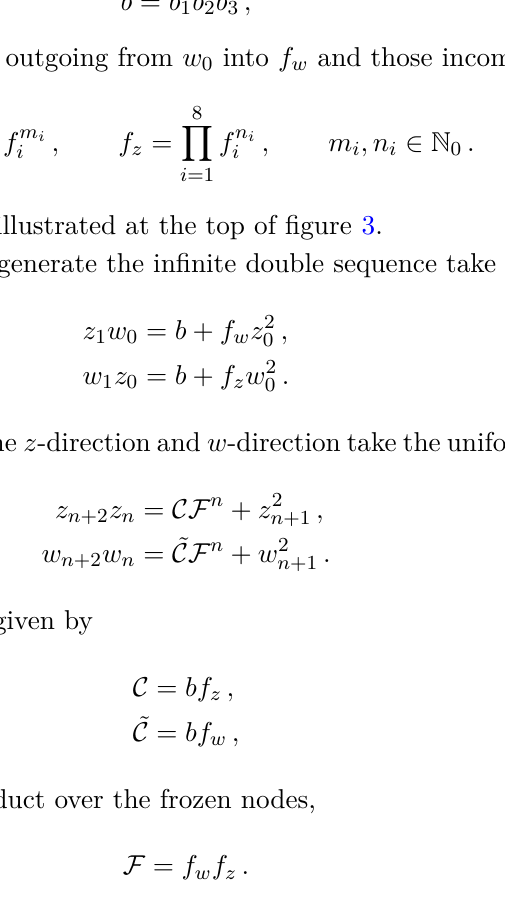
subalgebra of clusters containing the 2 × A 2